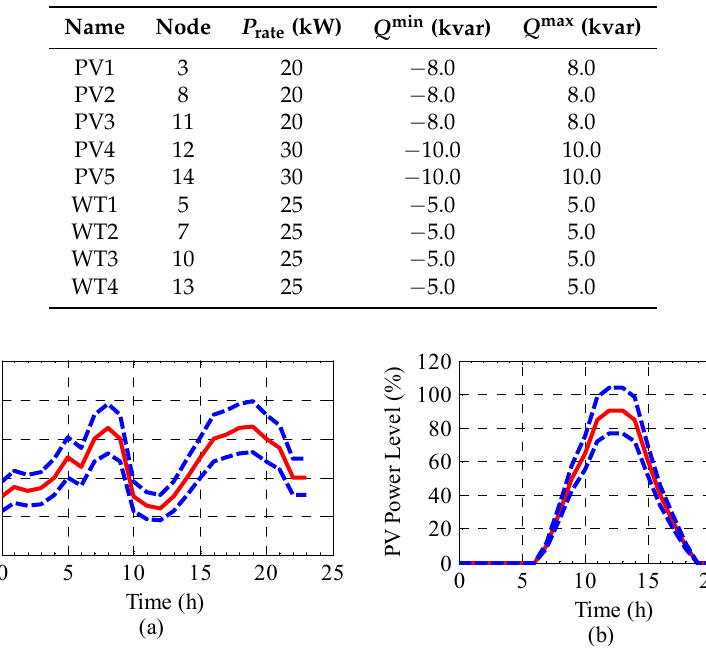
Figure 6. Power prediction intervals of PVs and WTs in 24 h (the dotted lines denote the upper and lower bounds, and the real lines denote predicted value). ( a ) Active power of WTs; ( b ) active power of PVs. Table 3. Parameters of energy storage units (ESUs), EVs and gas turbine (GT) of the